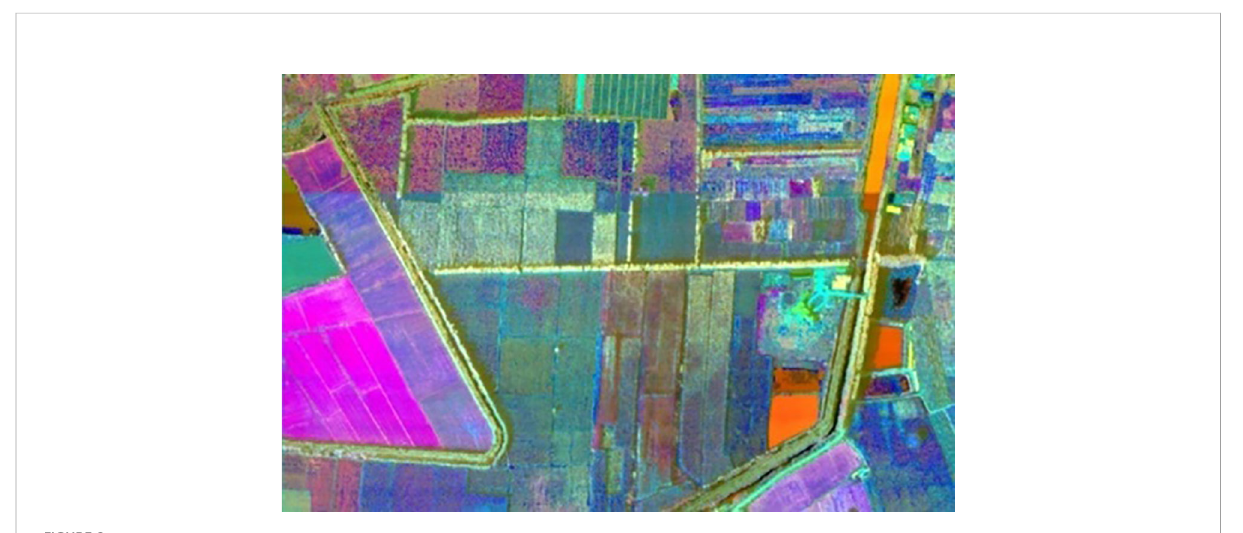
FIGURE 2 Pseudo color image after PCA.